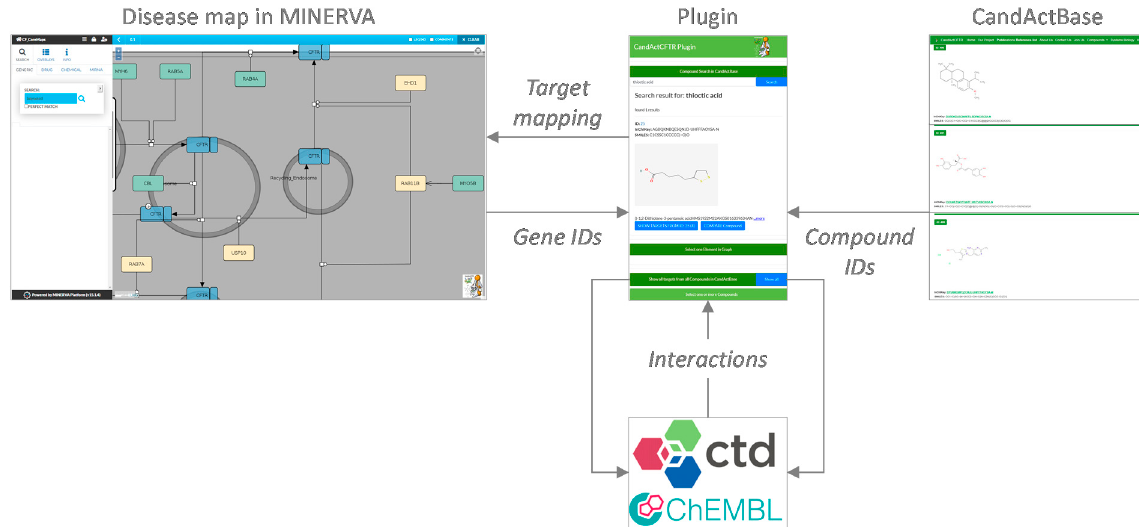
Figure 1. Concept and data flow of the plugin. Gene IDs and Chemical IDs are extracted from the disease map on MINERVA [3] (© Université du Luxembourg, 2021) and the CandActCFTR database, respectively. Using these unique identifiers, gene-chemical interactions are retrieved from the databases ChEMBL [6] (© EMBL-EBI 2018) and CTD [7] (© 2012–2021 NC State University) via the plugin. The results are then listed in the plugin and displayed in the disease map on